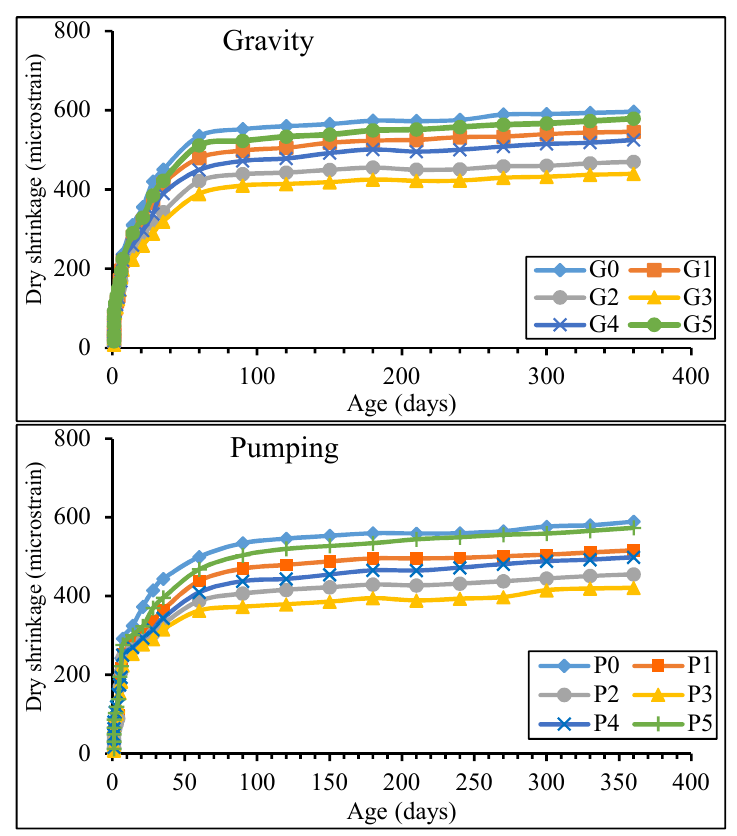
Figure 10. Long-term drying shrinkage of PAFRC specimens reinforced with PP fibres.